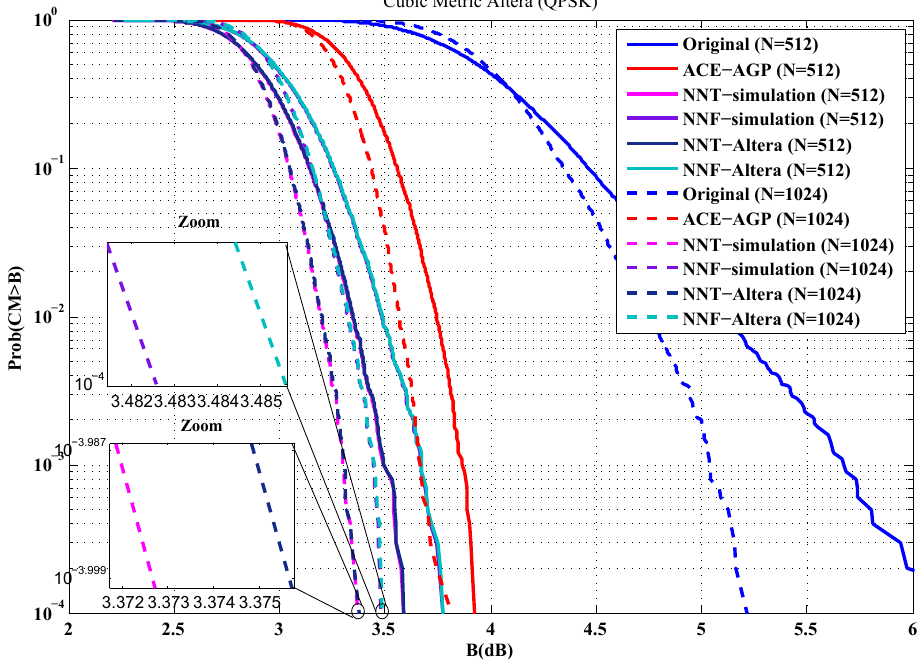
Figure 13. Cubic metric reduction in the case of QPSK modulation (Altera